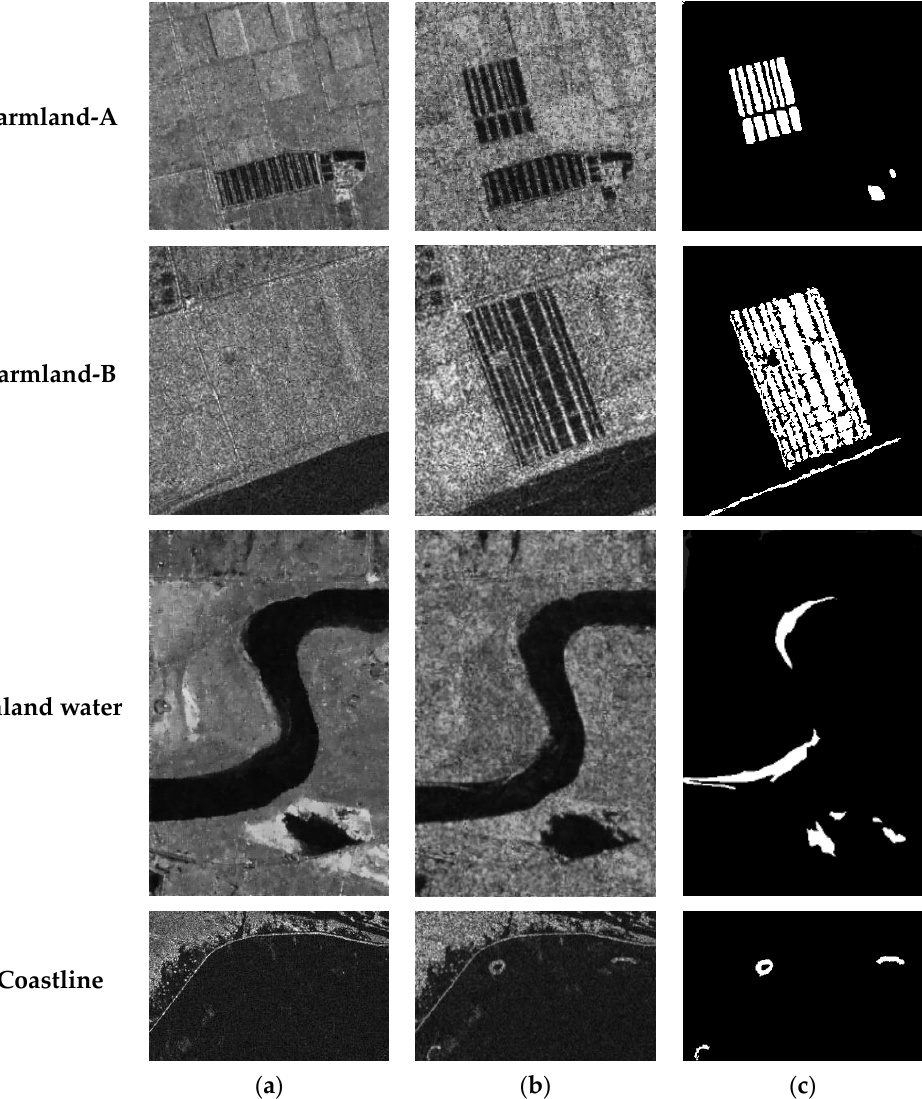
Figure 6. Sulzberger dataset. ( a ) Image acquired on 11 March 2011; ( b ) image acquired on 16 March 2011; ( c ) ground truth.